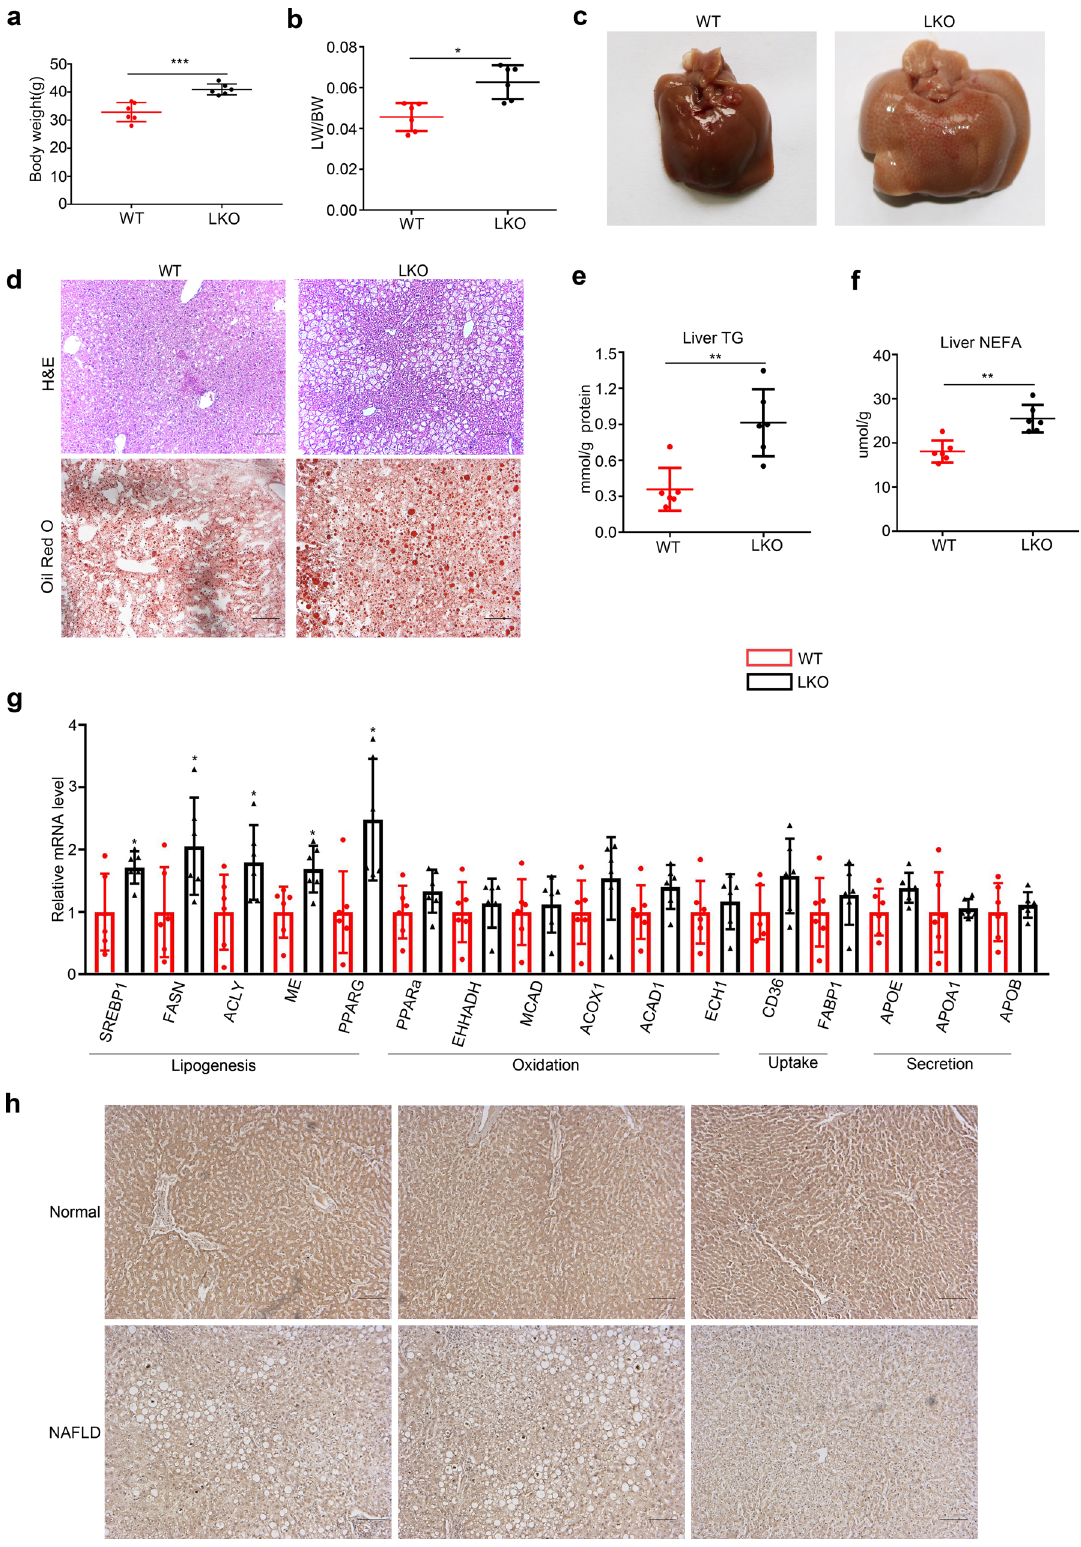
the mRNA levels of lipogenic genes (Supplementary Fig. 3f) in PPDPF-LKO mice after 3 months of HFD consumption. In sum, these fi ndings revealed that re-expression of PPDPF hindered HFD-induced NAFLD development in PPDPF-LKO mice, which con fi rmed the inhibitory effect of PPDPF on